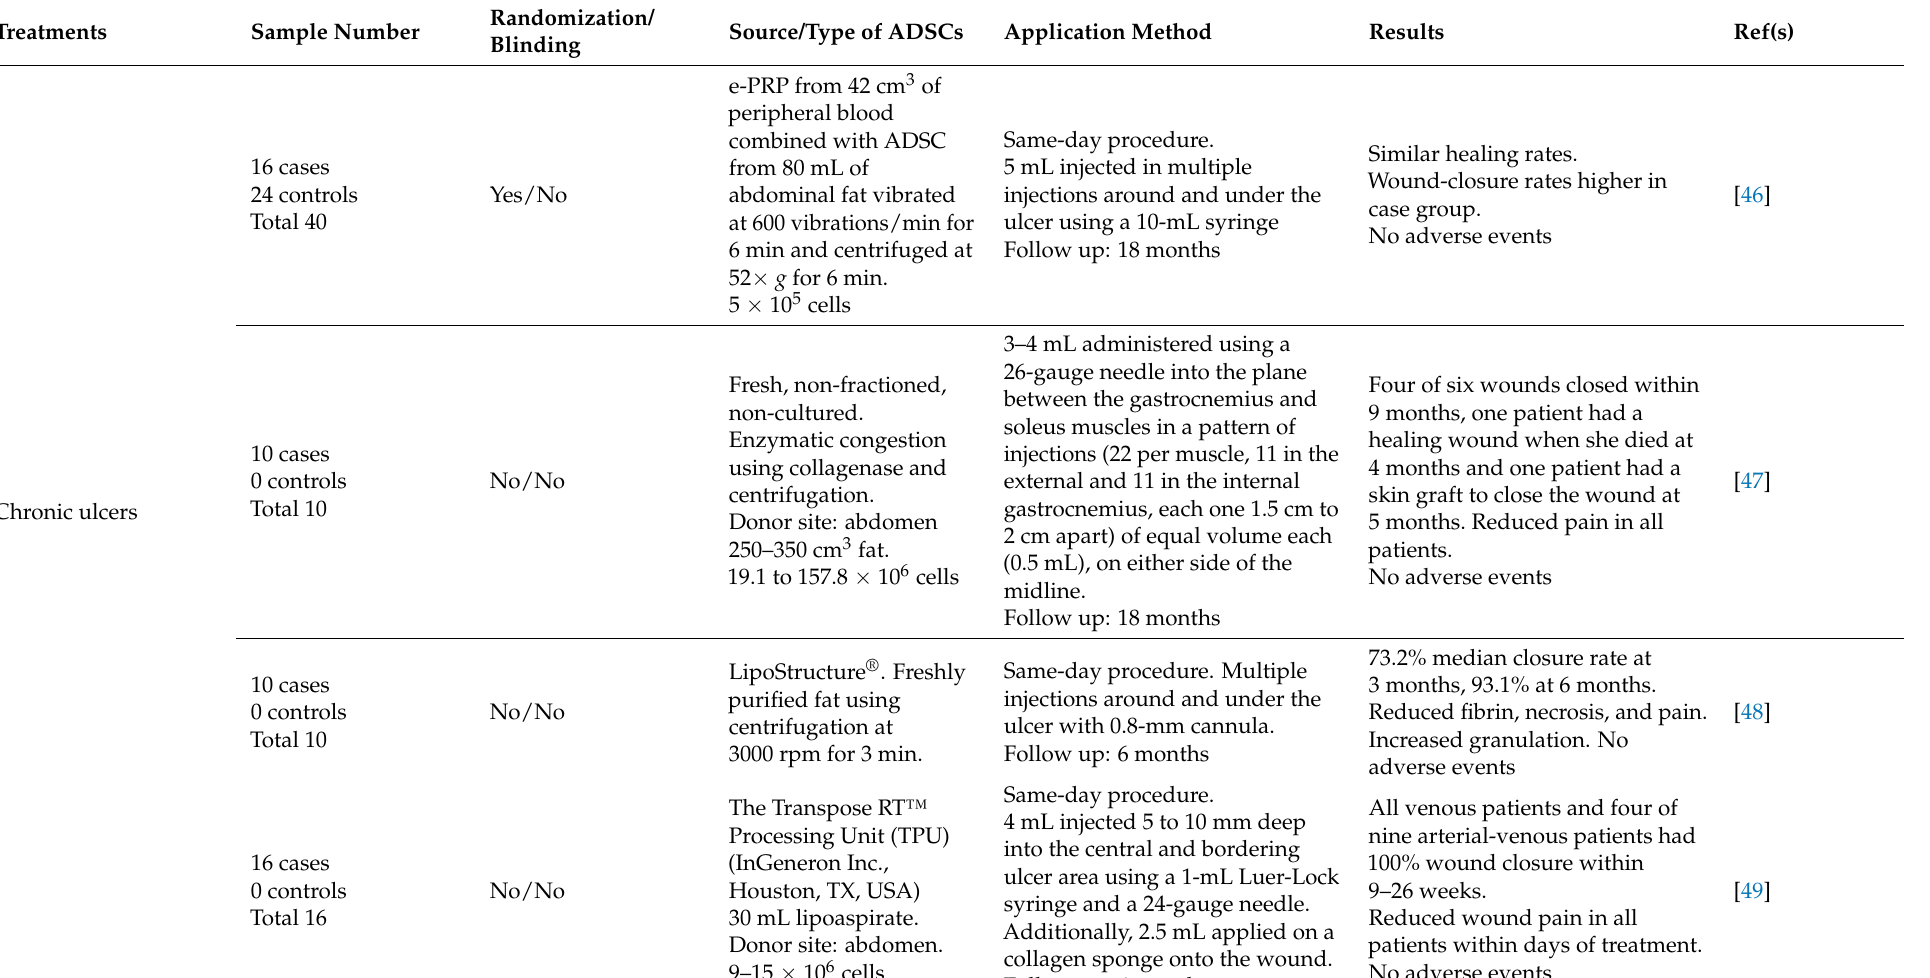
Table 3. The treatment using ADSCs in clinical